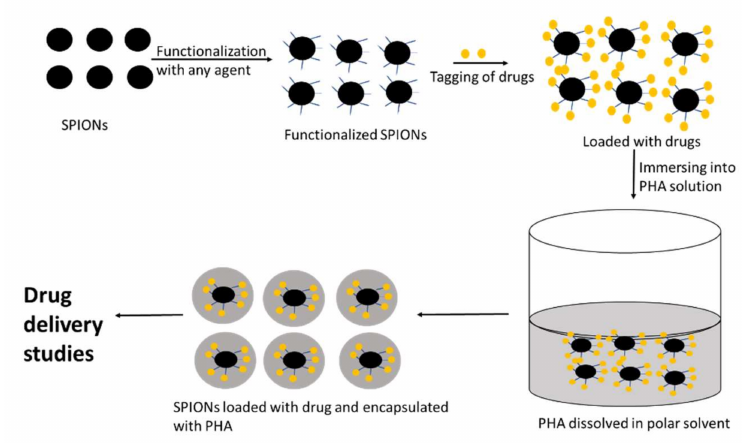
Figure 9. PHA-encapsulated SPIONs (Inspired from Samrot et al. [205]).